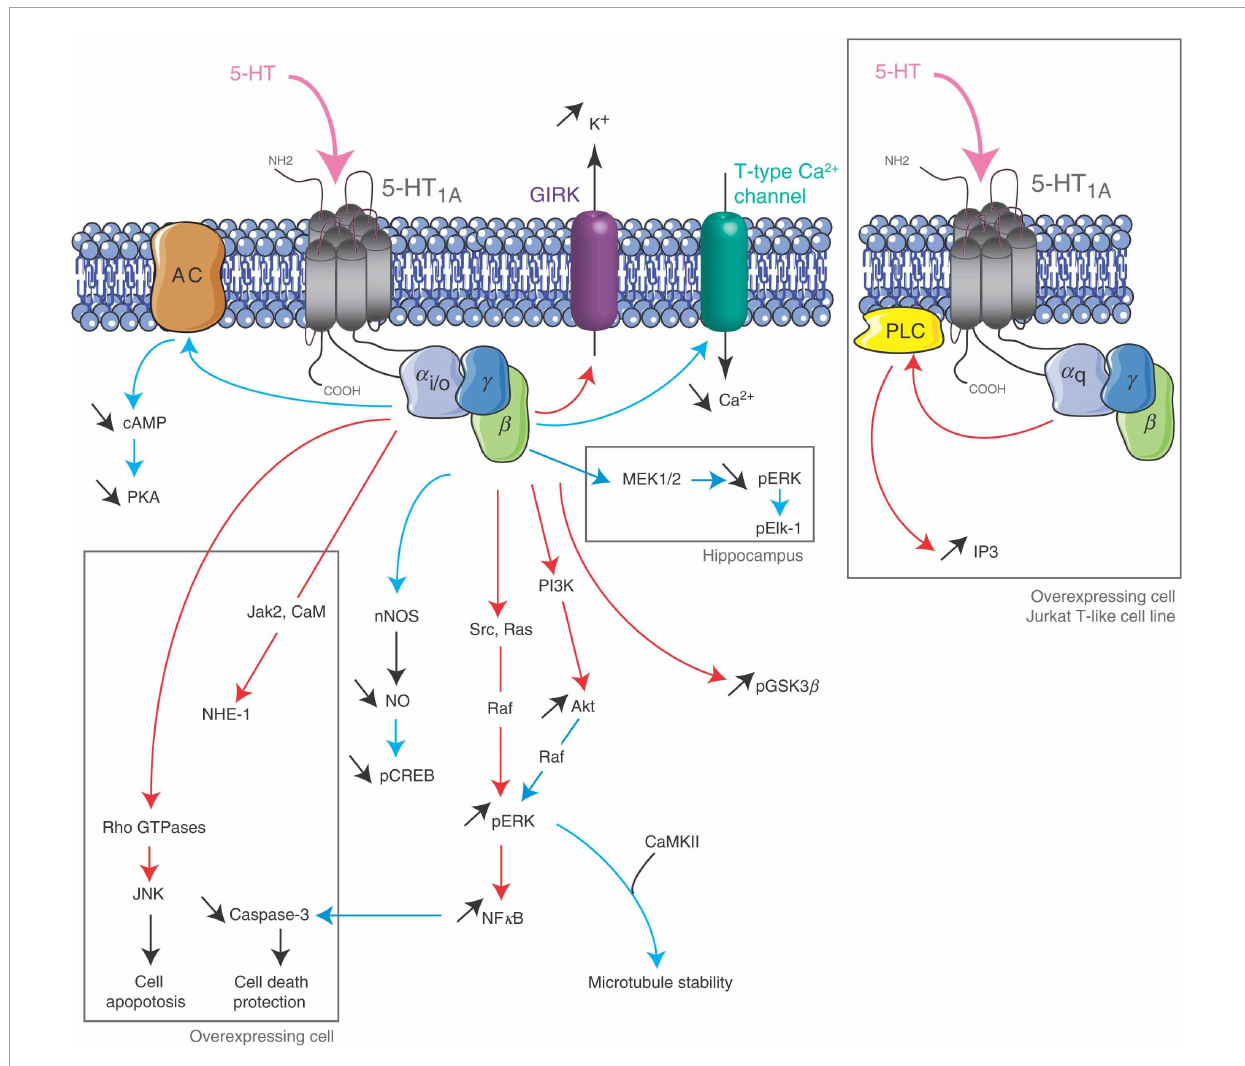
FIGURE9 5-HT2C receptor signaling pathways. The 5-HT2CR is coupled to PLC in neurons and choroid plexus, and its activation leads to an accumulation of IP3. It inhibits K + conductance in both neurons and choroid plexus and stimulates an apical Cl- conductance in choroid plexus. It may also be coupled to PLD in transfected cells and choroid plexus. Figure from Masson et al. (2012), obtained under a creative commons license 3 and